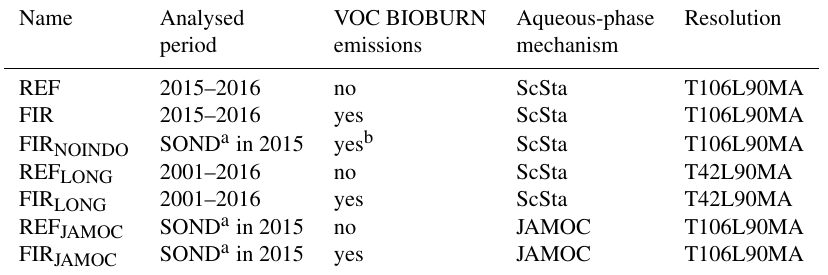
Table 1. List of EMAC simulations performed in this study. Here, ScSta indicates EMAC’s standard aqueous-phase mechanism (Jöckel et al., 2016) and JAMOC indicates the complex in-cloud OVOC oxidation scheme by Rosanka et al. (2021b, a) (for further details see Sect.